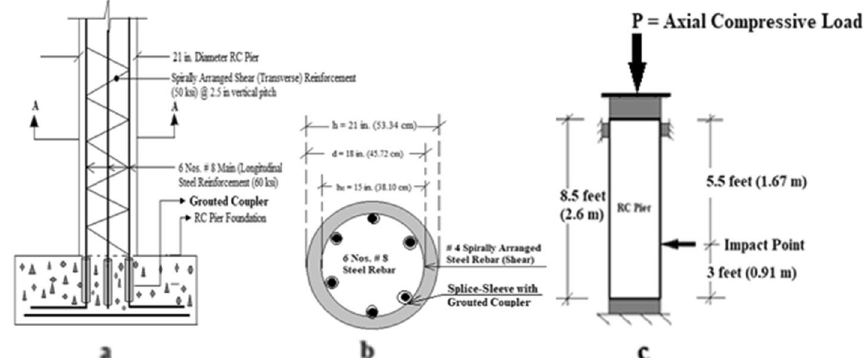
Fig. 4 Schematic diagram of coupler arrangement in a pier-foundation, b section A-A and c boundary conditions and loading